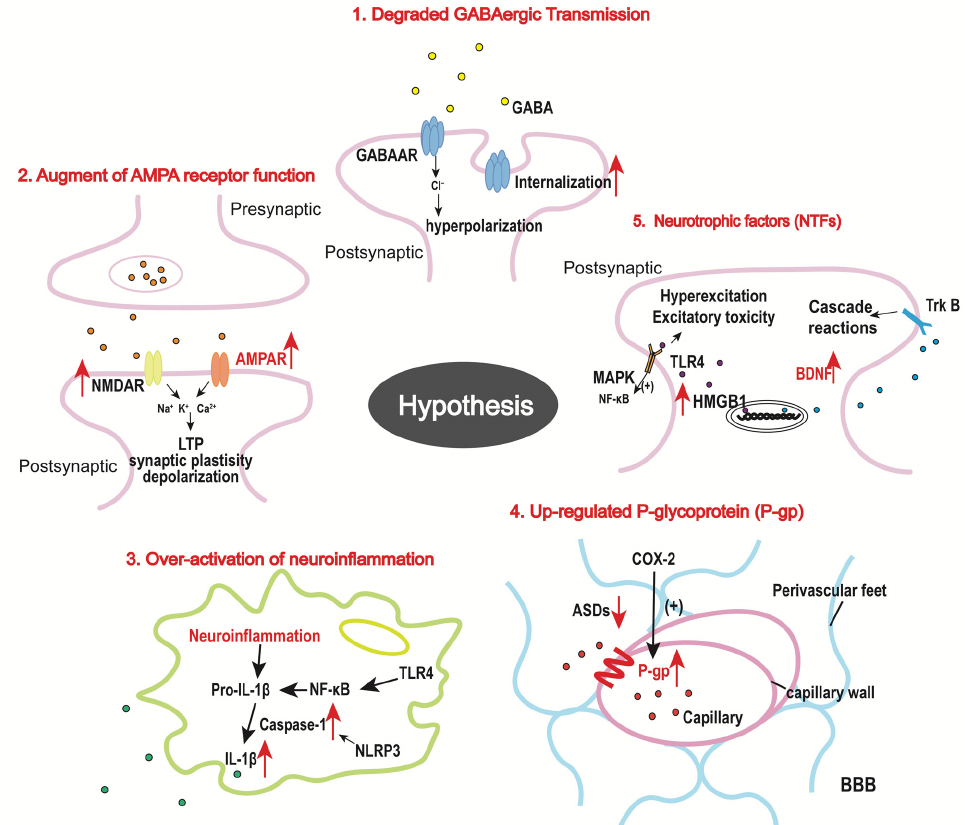
Figure 2. Schematic diagram of main drug resistance mechanism in SE. The red up and down arrows represent the increase or decrease.